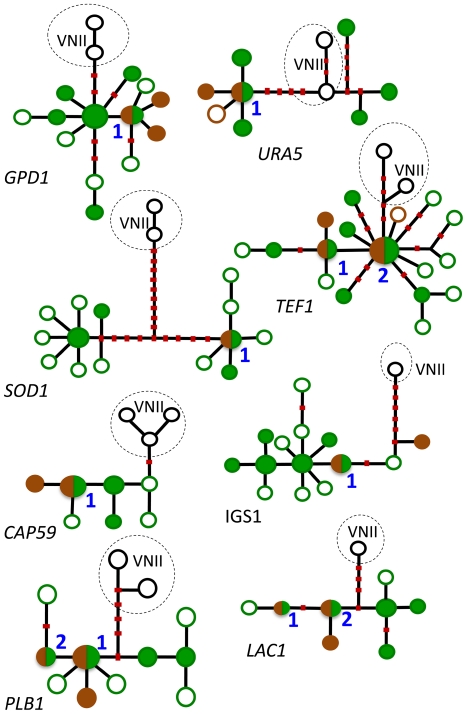
Haplotype networks of the eight MLST loci.Haplotypes of strains of C. neoformans var. grubii that have never been found outside Africa are shown in green: filled green circles designate haplotypes of strains that were obtained from trees (most were also found in patients), and empty green circles signify haplotypes that were obtained only from patients. Cosmopolitan haplotypes are shown in brown: filled brown circles designate haplotypes of strains from pigeon excreta (most were also found in patients), and empty brown circles signify haplotypes that were obtained only from patients. Circles that are half green and half brown, designated “1” and “2”, indicate haplotypes of strains found in trees and pigeon excreta, and they represent the ancestral haplotypes of global strains. Haplotypes from the global VNII subpopulation of C. neoformans var. grubii are used as an outgroup; they are shown in black and lightly encircled. Ancestral haplotypes are internal, and derived haplotypes occupy apical positions. Red dots on the lines connecting the haplotypes represent the most parsimonious number of mutational steps required to generate the allelic polymorphisms. Recombinant haplotypes identified by ARGs are excluded. The number of haplotypes per locus can also be observed. For example, 11 GPD1 haplotypes were detected in Africa (empty, solid or half-filled green circles), and only three GPD1 haplotypes were found among the global strains (empty, solid or half-filled brown circles). (One exception is the TEF1 locus, which has 16 African haplotypes, but only 15 are depicted because one haplotype was found in a pigeon strain [D16-16].) Overall, the non-recombinant African to global haplotype ratios varied from 6 to 3 for URA5 to 14 to 1 for SOD1 (Table 1).